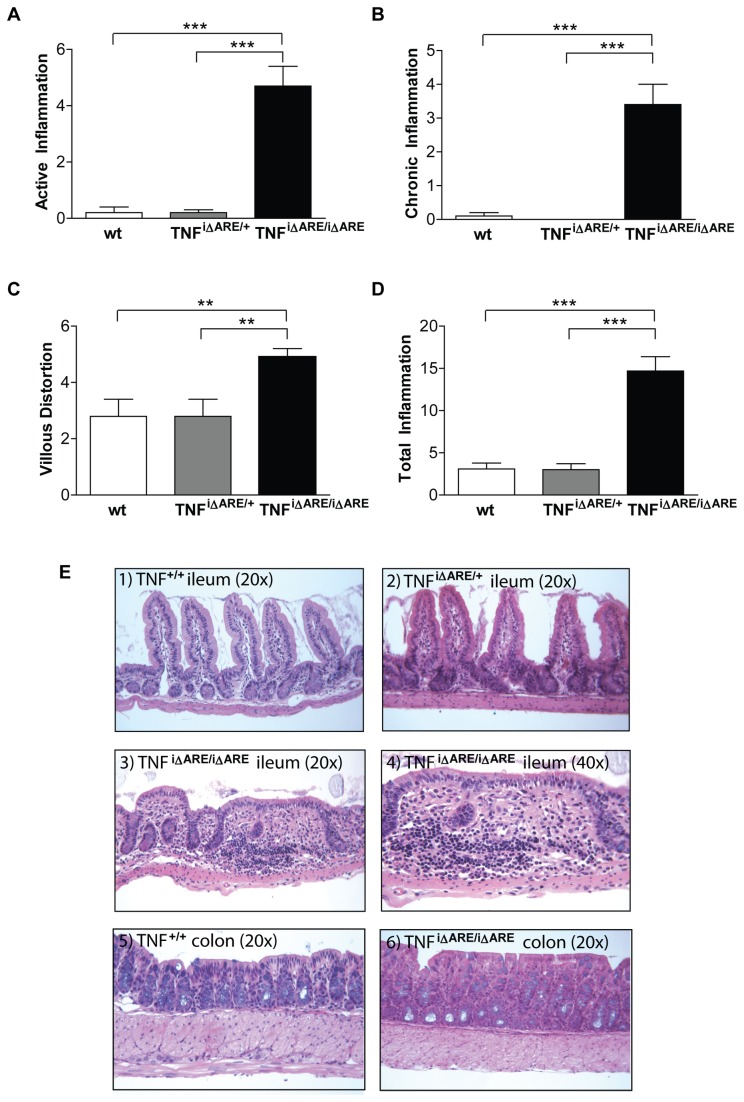
Histopathological features of TNFi∆ARE/i∆ARE mice.Histological assessment of inflammation in the terminal ileum was done using a validated scoring system. Indices were calculated for (A) villous distortion, (B) active inflammation (neutrophil infiltration), and (C) chronic inflammation (mononuclear cell infiltration). (D) The total inflammatory score represents the sum of all 3 individual indices. Values for all indices were significantly elevated in homozygous TNFi∆ARE/i∆ARE mice (n=11), whereas no inflammatory changes were detected in heterozygous TNFi∆ARE/+ mice (n=10) or wt mice (n=10); all mice were evaluated at 16-20 weeks of age. Graphs represent mean values ± SEM for each group of mice. *P<0.05, ** < P<0.01, *P<0.001. (E) Representative photomicrographs of H&E stained sections from wt TNF+/+, TNFi∆ARE/+, and TNFi∆ARE/i∆ARE mice. 1) wt TNF+/+ ileum showing normal villous architecture with no blunting or evidence of acute or chronic inflammatory infiltration, 20x. (2) TNFi∆ARE/+ ileum showing mild villous blunting with no significant inflammation, 20x. (3) TNFi∆ARE/i∆ARE ileum showing evidence of chronic ileitis with villous blunting; acute and chronic inflammatory infiltration is seen within the LP and extending into the submucosa, 20x. (4) Higher magnification of ileum histology from a TNFi∆ARE/i∆ARE mouse showing evidence of marked inflammatory infiltration and distortion of normal villous architecture and crypts, 40x. (5) Colon histology of wt TNF+/+ mice showing no evidence of colonic inflammation, 20x. (6) Colon histology of a TNFi∆ARE/i∆ARE mouse showing normal colonic histology with only a few lymphocytes infiltrating the LP.